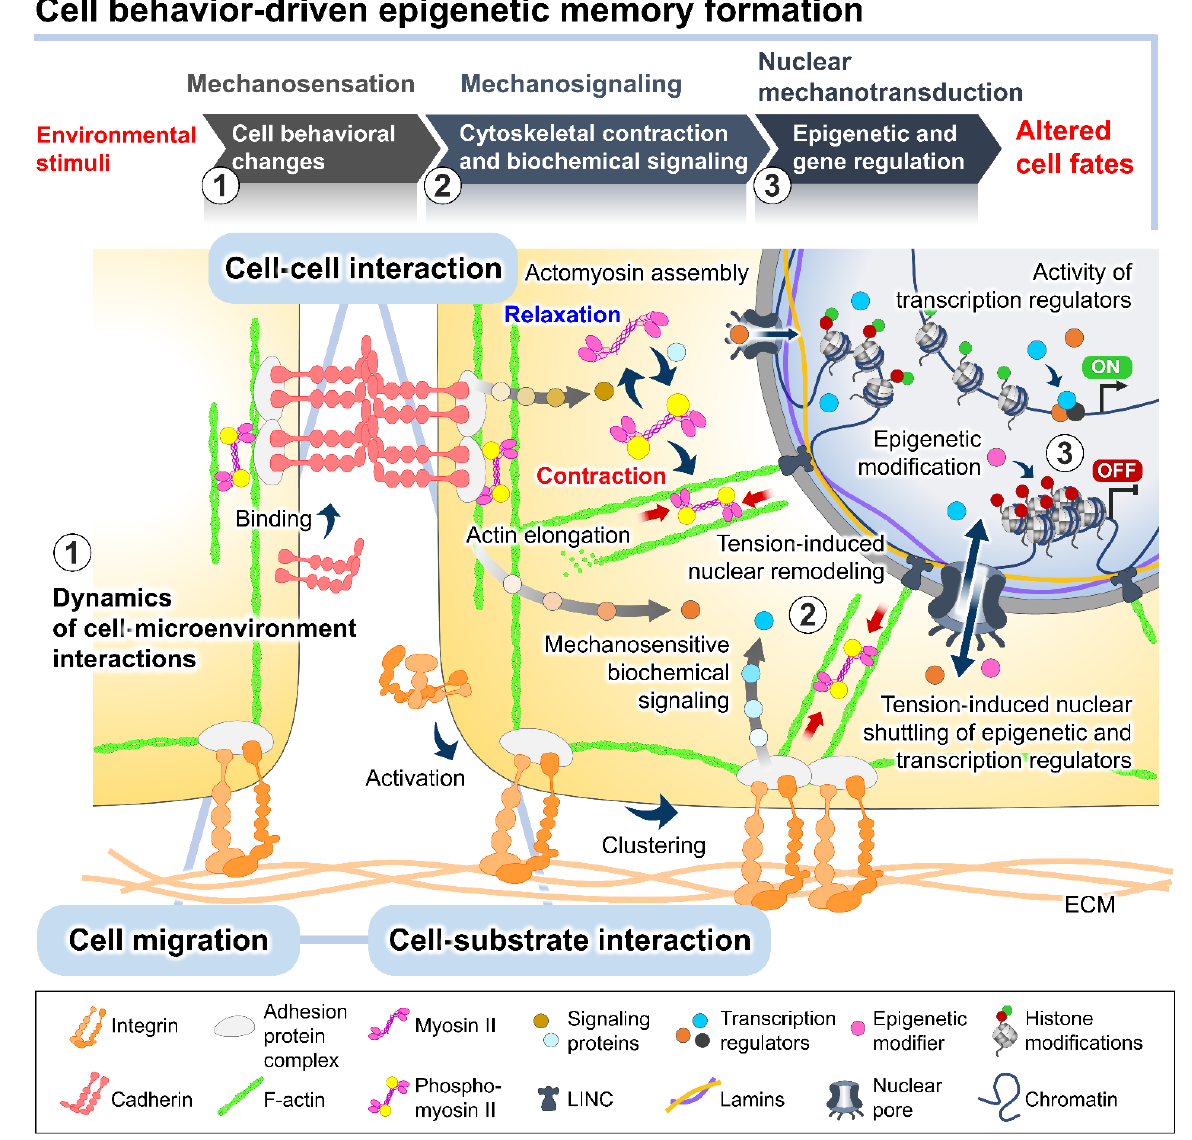
Figure 2. The plausible interplay between cell behavioral dynamics and intracellular mechanical regulation in cell fate modulation. In the culture microenvironments, cells sense and respond to extrinsic mechanical stimuli from the culture substrate, surrounding cells, and fluid dynamics exerted on cellular membranes and different biomechanosensors, such as integrins and E-cadherins. The alteration of the integrin-mediated cell – substrate and E-cadherin-mediated cell – cell adhesion behaviors triggered by the extrinsic forces can stimulate a wide range of intracellular biochemical signaling cascades and induce intrinsic force generation by regulating the actomyosin cytoskeletal contractility. The distribution of the intrinsic cytoskeletal tension mediates the nuclear structural remodeling and cytoplasmic-nuclear shuttling of several mechanosensitive transcription regulators, influencing the intranuclear events, such as epigenetic modifications and gene transcriptional activity, and consequently altering cell fates and functions. The binding of cell adhesion molecules promotes the recruitment of multiple struc- tural and signaling proteins at the cytoplasmic domains. The association of adhesion pro- tein complexes primarily facilitates a direct force transmission from adhesion contacts